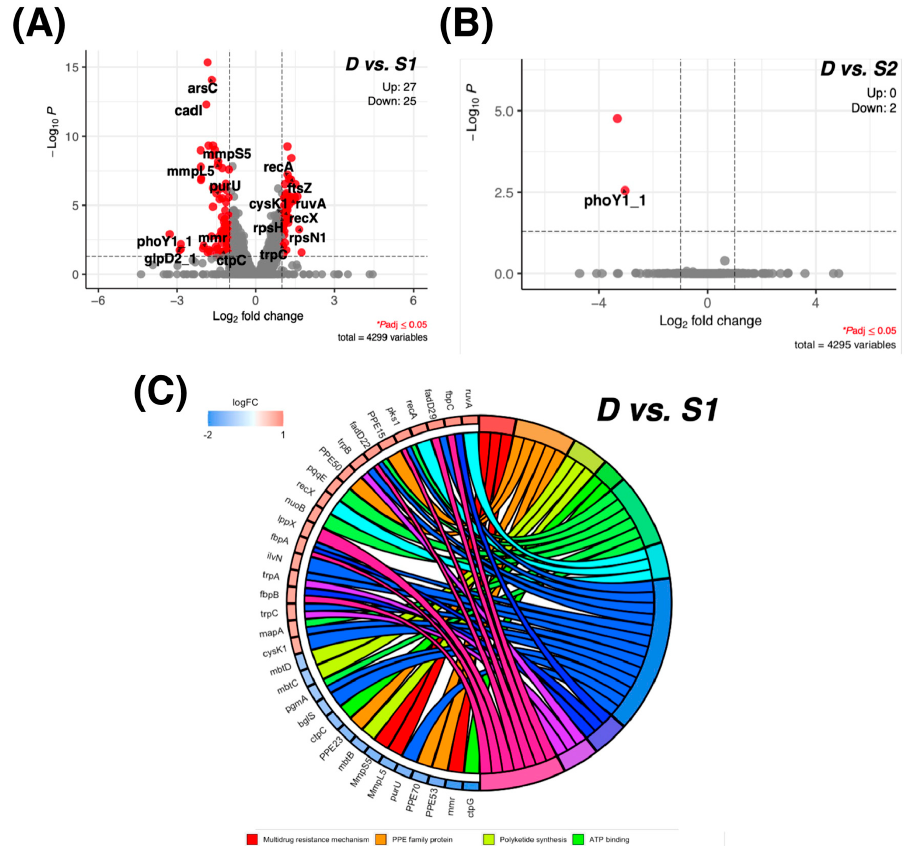
Figure 4. Molecular regulation associated with the anti ‐ virulence process. ( A ) Volcano plot of the DEGs between D and S. ( B ) Volcano plot of the DEGs between D and S2. ( C ) Molecular functions and biological processes enriched in the DEGs for the survival groups.